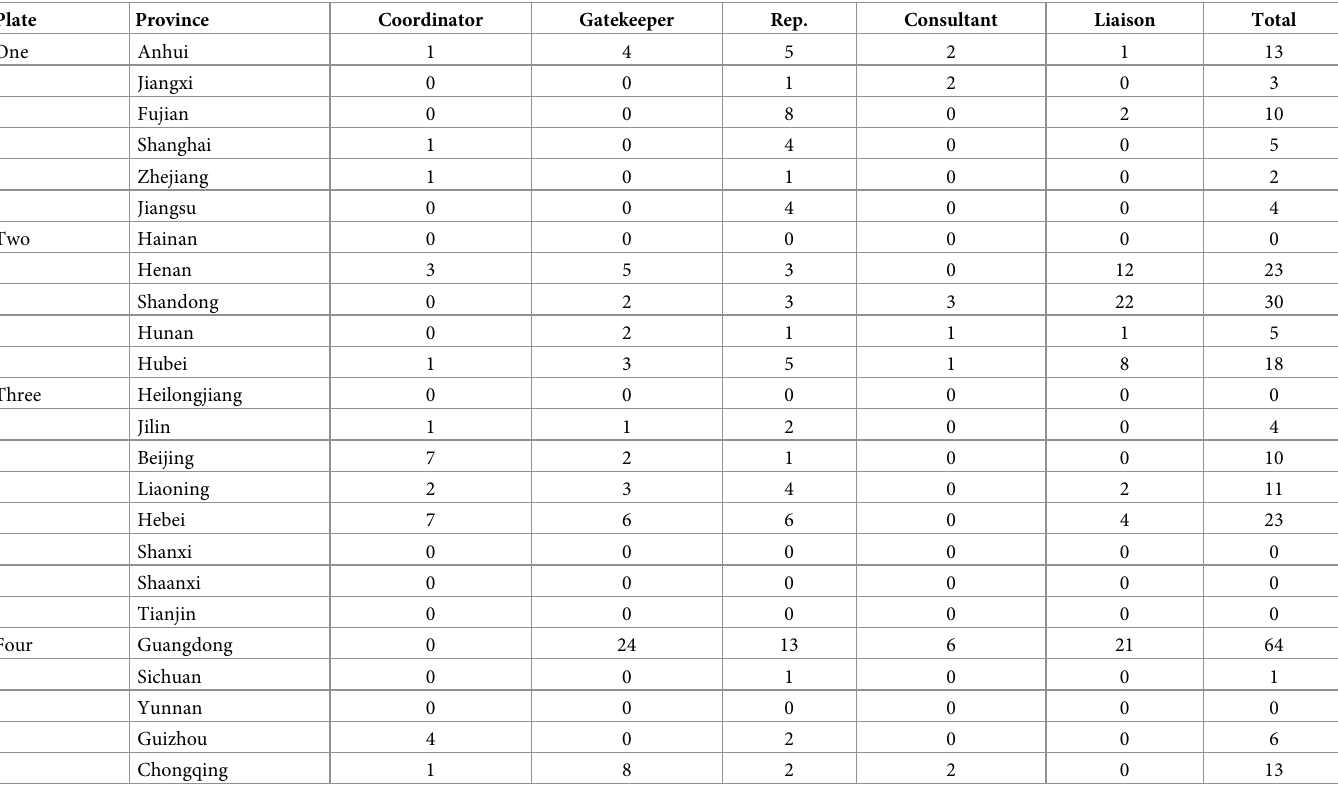
Table 4. Number of middlemen in provinces in the innovation efficiency correlation network of China’s new energy vehicle industry. Plate Province